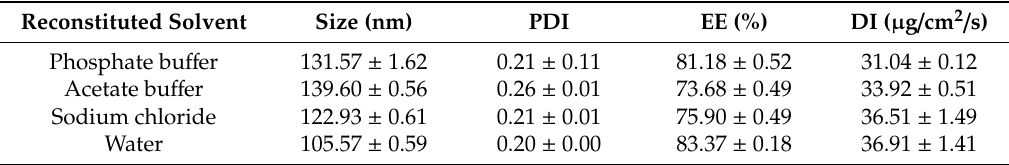
Table2. E ff ectofdi ff erentreconstitutedsolventonthesize, PDI,entrapmente ffi ciency, anddeformability index of IPC-DNVs after lyophilization ( n =